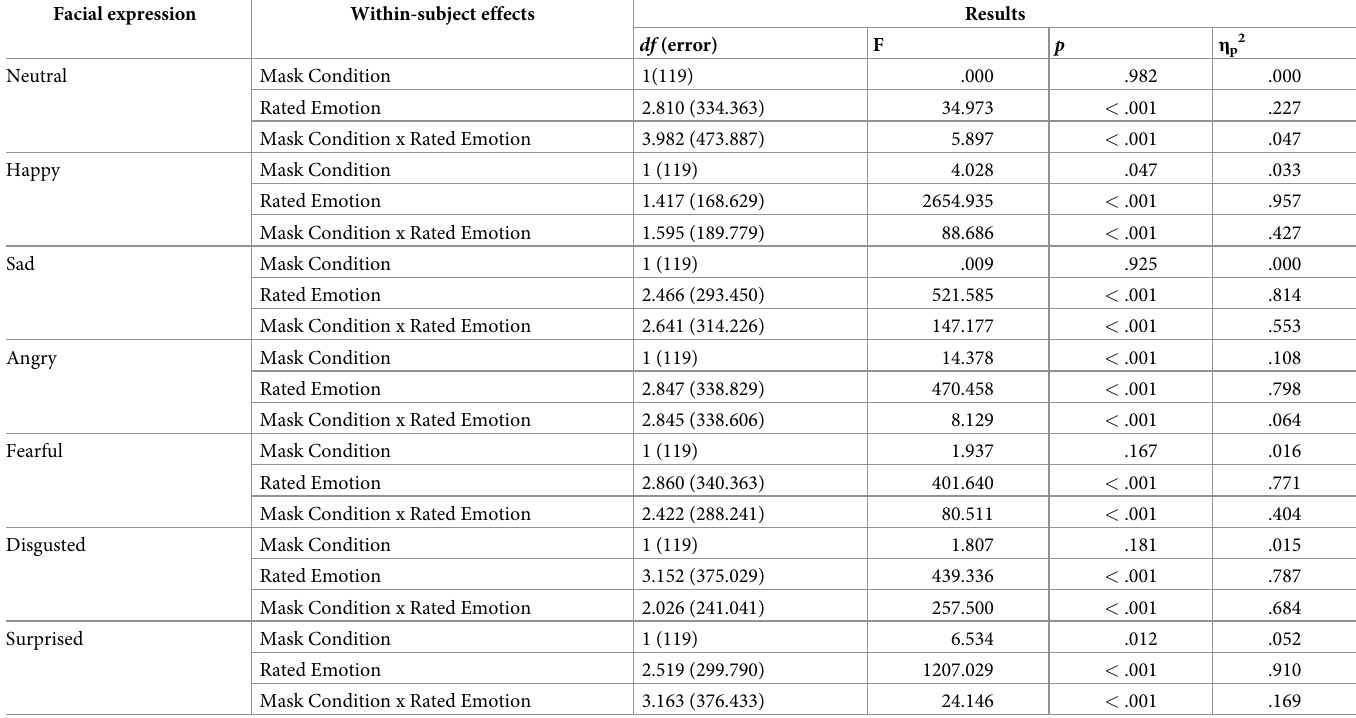
Table 1. Results of ANOVAs on the effects of Mask Condition and Rated Emotion on emotion intensity ratings. Facial